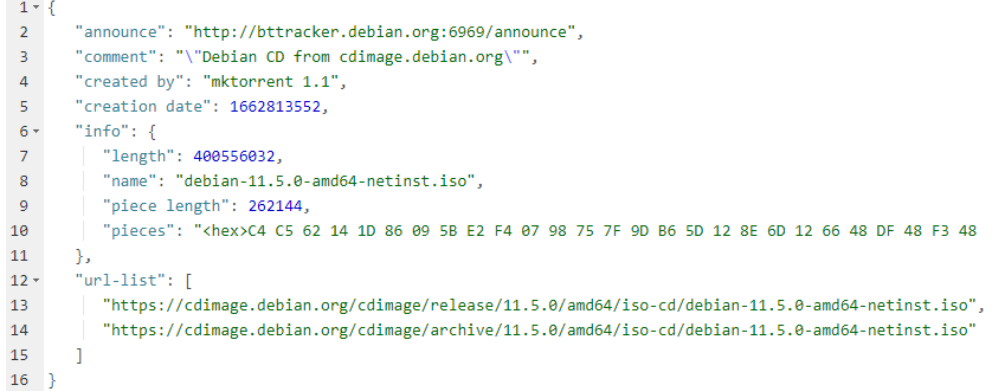
Figure 3. Debian 11.5.0 torrent file